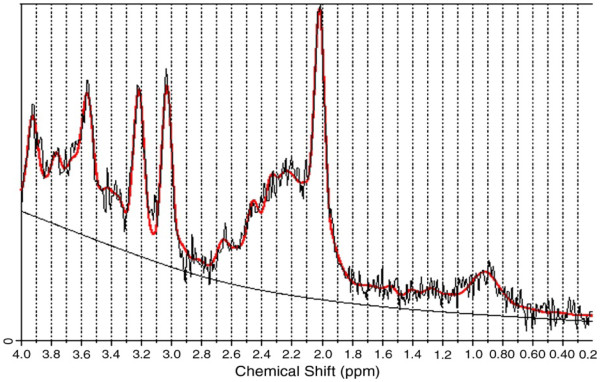
An example of typical MR spectra from the right parietal lobe. The in vivo data and fitted baseline are shown in black, with the LCModel fit overlaid in red.